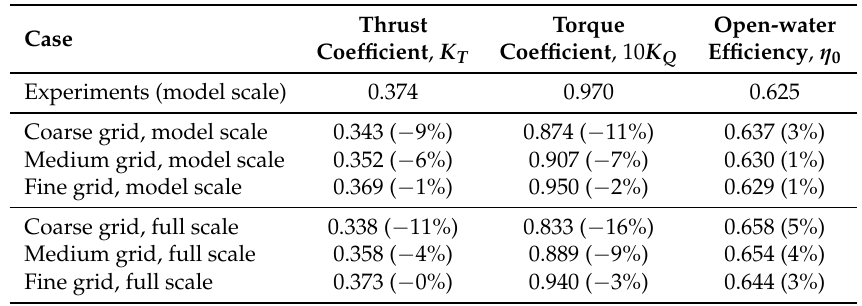
Table 5. Predicted thrust and torque coefficients with the different grid densities for PPTC Case 1. The percentage difference to the model-scale values from the experiments is given in parentheses. Case